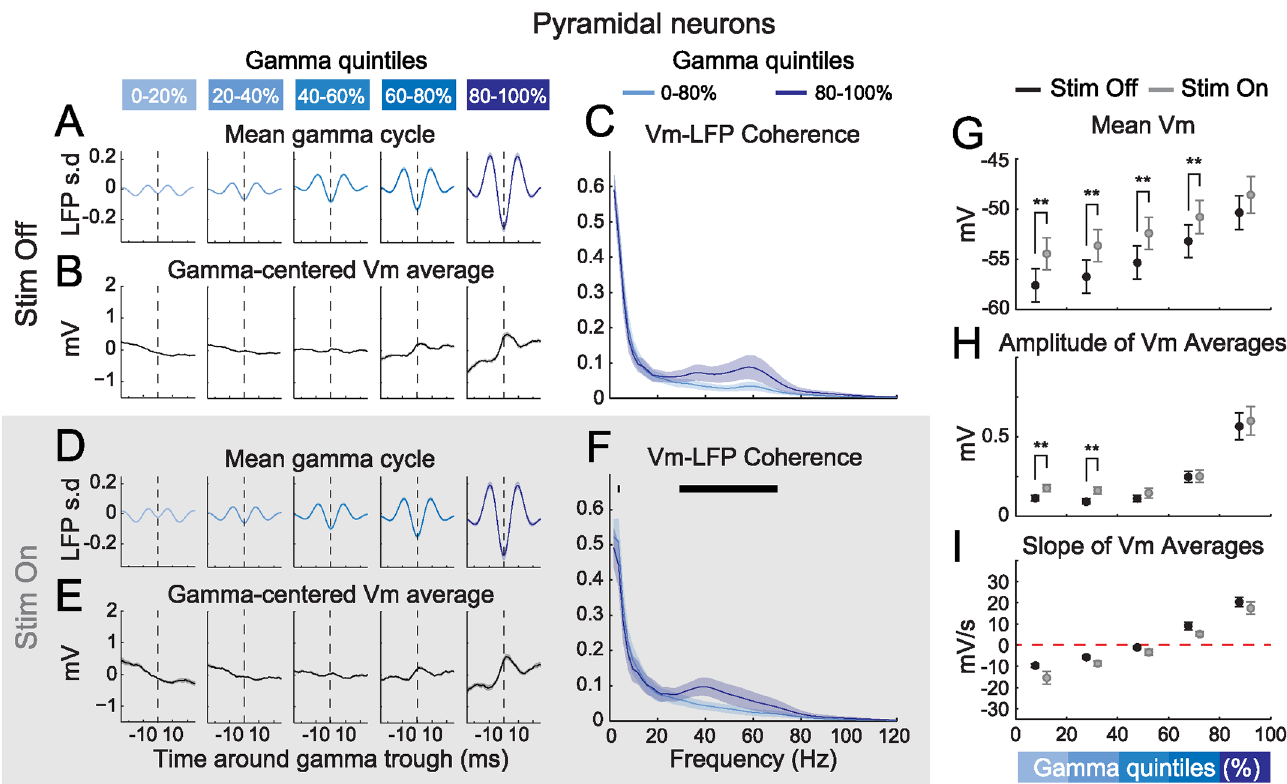
Fig 6. Strong gamma oscillations entrain Vm in PYRs and occur when PYRs depolarize. ( A, D ) Grand mean of trough-centered segments of the gamma-filtered LFP, outside (A) and during (D) visual stimulation, as a function of gamma quintile at trough time ( n = 10; shaded areas: +/- s.e.m.). ( B, E ) Grand mean of simultaneously recorded PYR Vm segments ( n = 10; shaded areas: +/- s.e.m.). ( C, F ) Strong gamma oscillations increase PYR Vm-LFP coherence in the gamma range (30 – 80 Hz) outside (C) and during (F) visual stimulation ( n = 10; light and dark blue traces: grand mean coherence respectively in the four weakest quintiles and in the strongest gamma quintile; shaded areas: +/- s.e.m; black horizontal line: statistical significance between the four weakest quintiles and the strongest gamma quintile, FDR corrected signed-rank test, α = 0.05). ( G ) Grand mean DC Vm of PYRs as a function of gamma quintile outside (Stim Off, black) and during (Stim On, grey) visual stimulation ( n = 10; error bars: s.e.m.; ** : p < 0.01, signed-rank test). ( H ) Grand mean amplitude of gamma-centered Vm averages outside (Stim Off, black) and during (Stim On, grey) visual stimulation ( n = 10; error bars: s.e.m.; ** : p < 0.01, signed-rank test). ( I ) Grand mean slope of linear fits to gamma-centered Vm averages outside (Stim Off, black) and during (Stim On, grey) visual stimulation ( n = 10; error bars: s.e.m.).